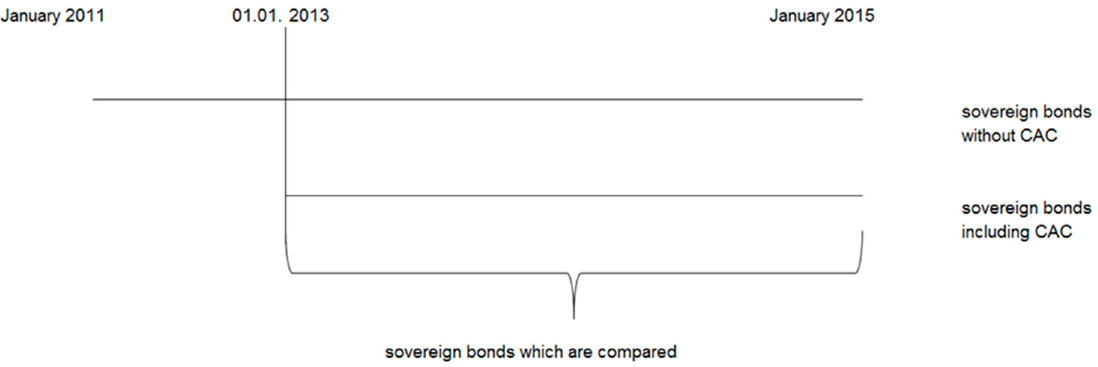
Figure 1. Event window for the empirical analysis (Source: Authors).